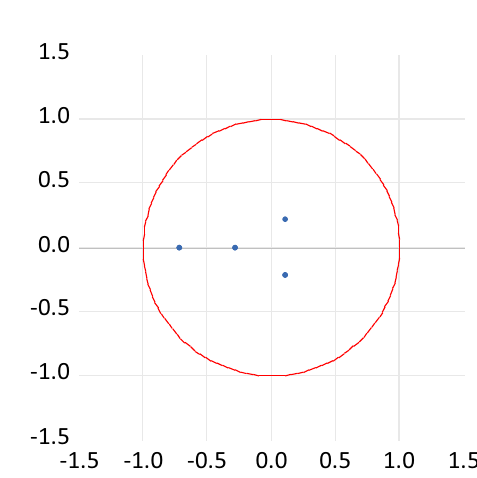
Fig. 1 Inverse roots of AR characteristic polynomial.